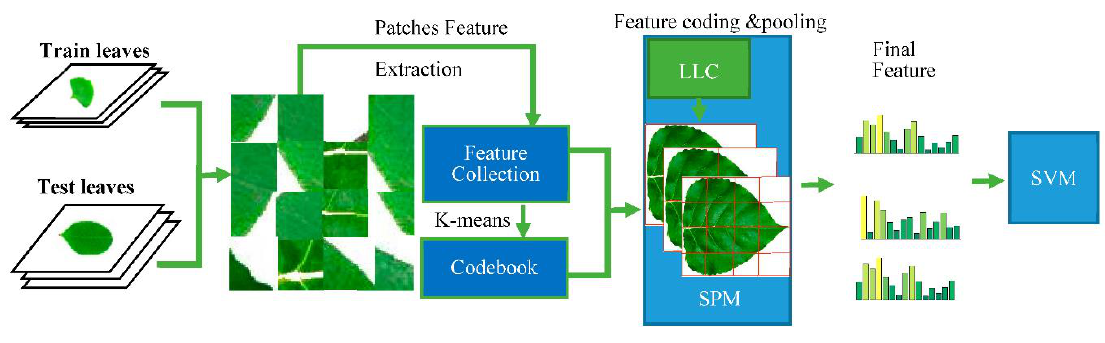
Figure 2. BOF classification system.